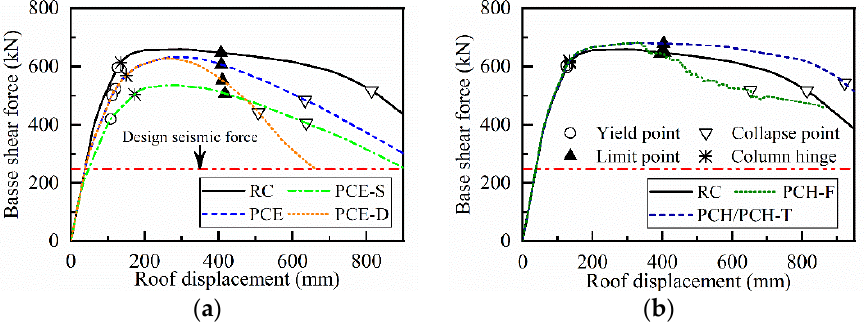
Figure 11. Pushover curves of frames: ( a ) Comparison of emulated frames and the RC frame; ( b ) comparison of non-emulated frames and the RC frame.